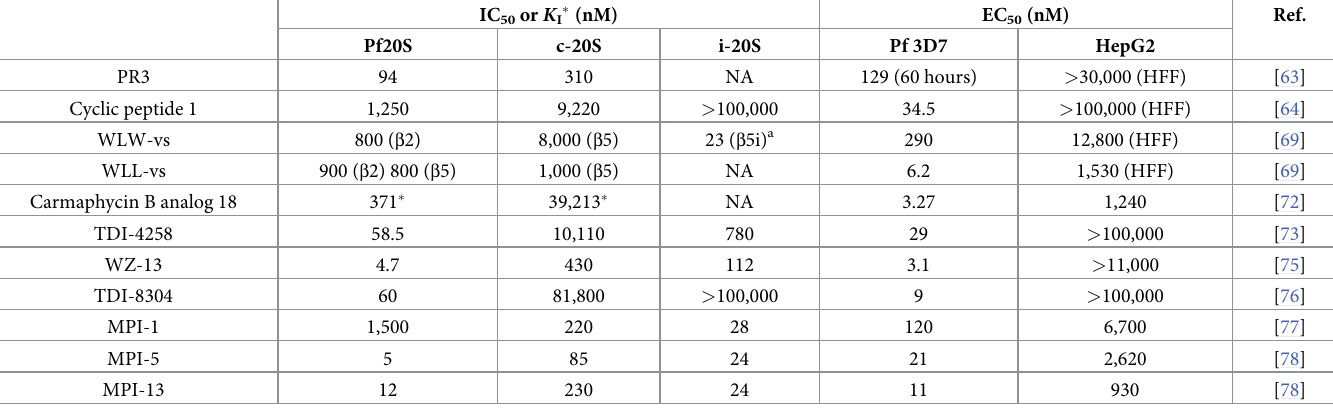
Table 2. Inhibitory activity of Pf20S inhibitors and antimalarial